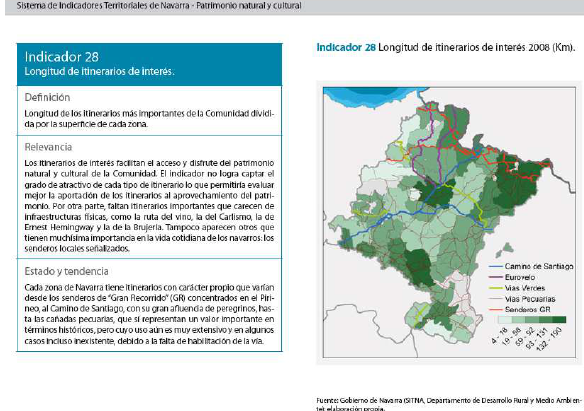
Figure 2- Navarra, Spain lists easy to read indicators, in this case cultural routes with numerous maps including Pamplona.